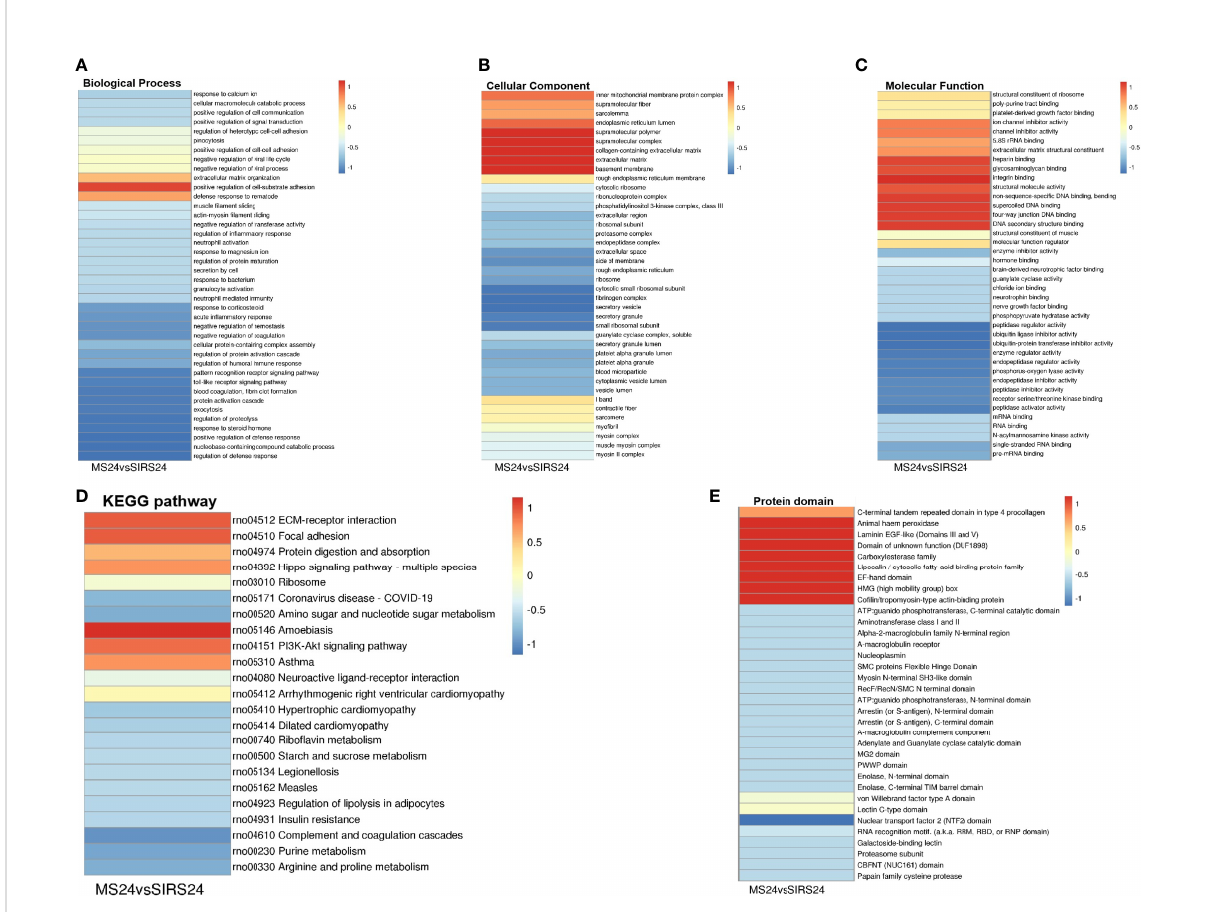
FIGURE 4 Cluster analysis of DEPS. The biological process cluster analysis of GO (A) . The cellular component analysis of GO (B) . The molecular function analysis (C) . The KEGG pathway cluster analysis (D) . Tthe protein domain cluster analysis (E)